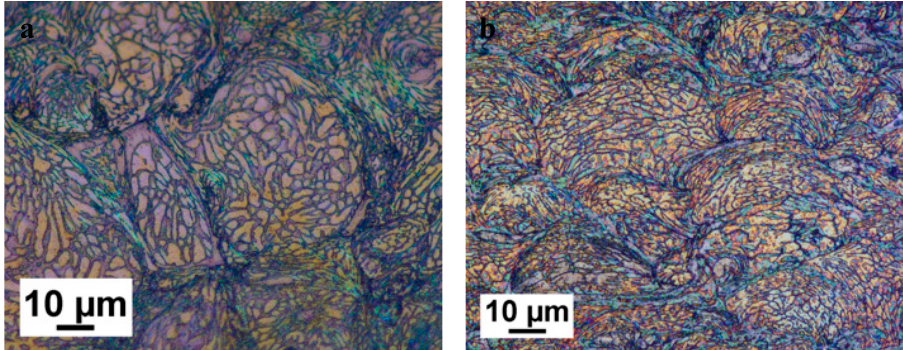
Figure 28. Optical micrograph of cold spray Al 6061 that was etched using Weck’s reagent and viewed under polarized light. ( a ) Spray direction is parallel to the orientation shown; ( b ) cross-section of cold spray sample where the spray direction is perpendicular.